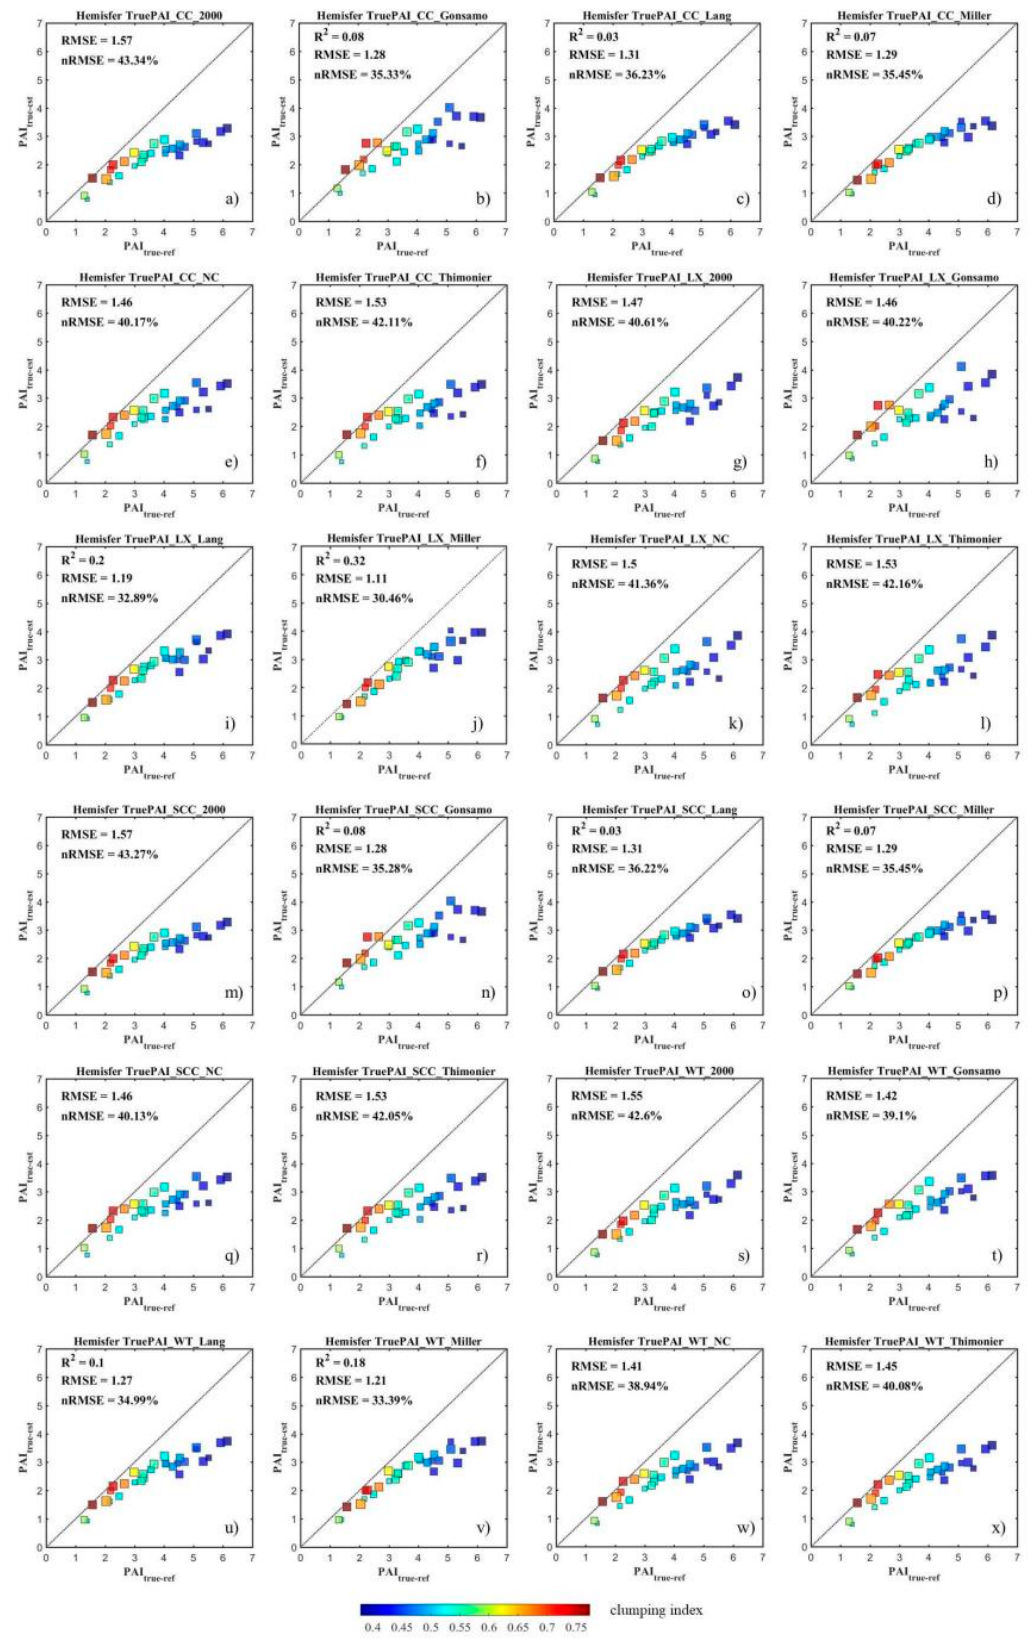
Figure 9. PAI true results from Hemisfer using different algorithms including the ( a ) CC_2000, ( b ) CC_Gonsamo, ( c ) CC_Lang, ( d ) CC_Miller, ( e ) CC_NC, ( f ) CC_Thimonier, ( g ) LX_2000, ( h ) LX_Gonsamo, ( i ) LX_Lang, ( j ) LX_Miller, ( k )